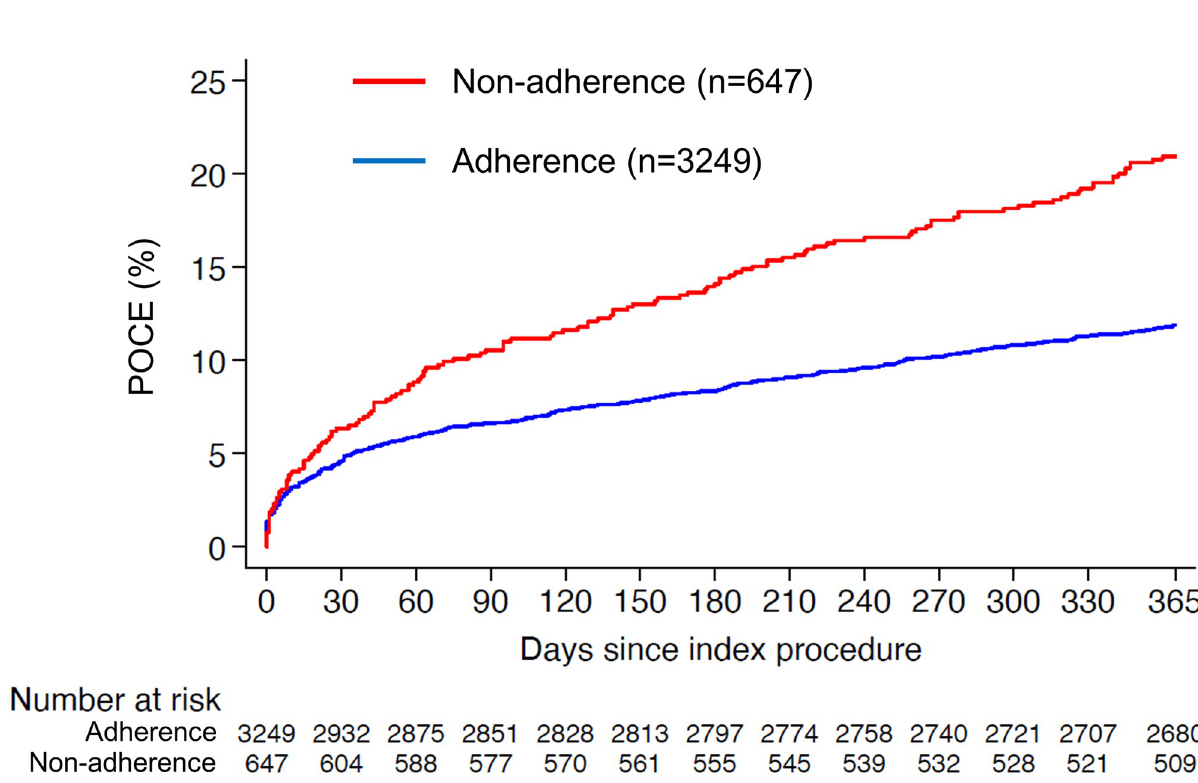
Fig 3. Kaplan-Meier cumulative event curve for POCE at 1 year. POCE = patient-oriented composite